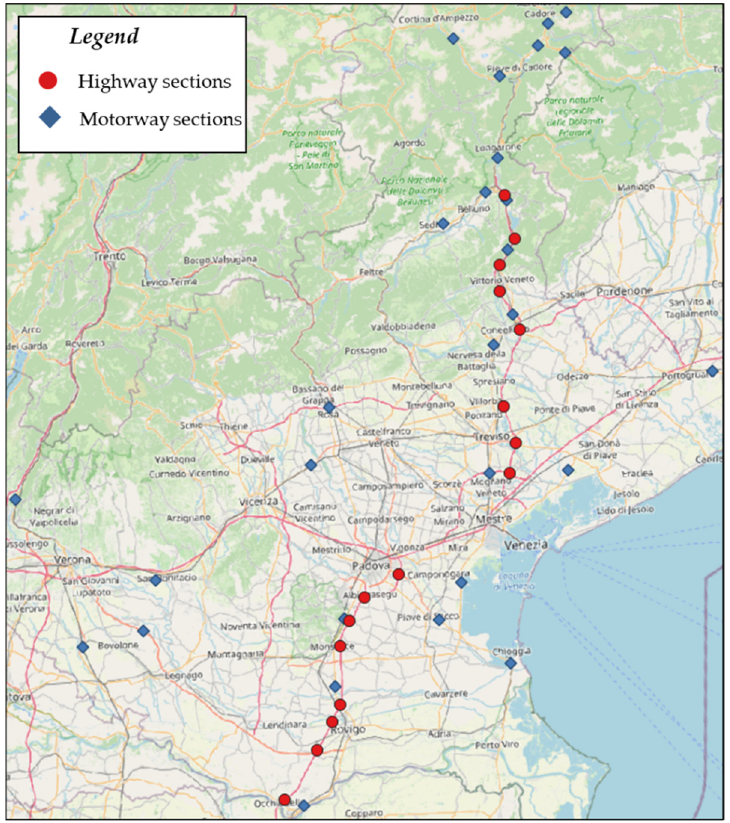
Figure 7. Traffic counts available in the Veneto region (background source: OpenStreetMap). Table 7. Link flow estimation: accuracy of